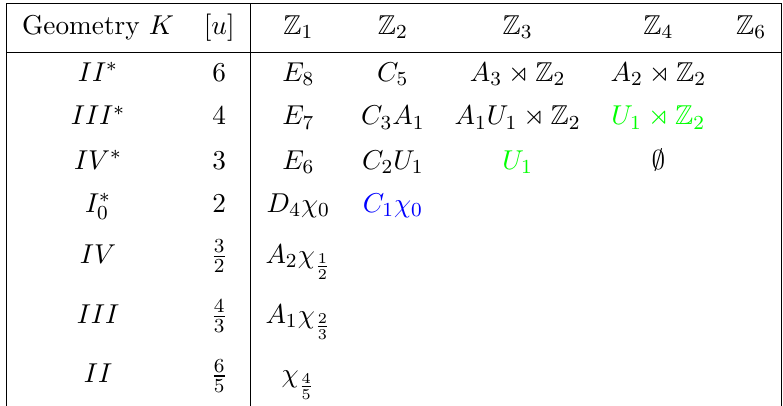
Table 1 . Left : list of the seven singular Coulomb branch geometries at rank 1. These are freely generated, and [ u ] is the scaling dimension of the generator. Right : list of 4d (IR-free theories are omitted). Each entry represents one theory, labeled by its (cid:13)avor